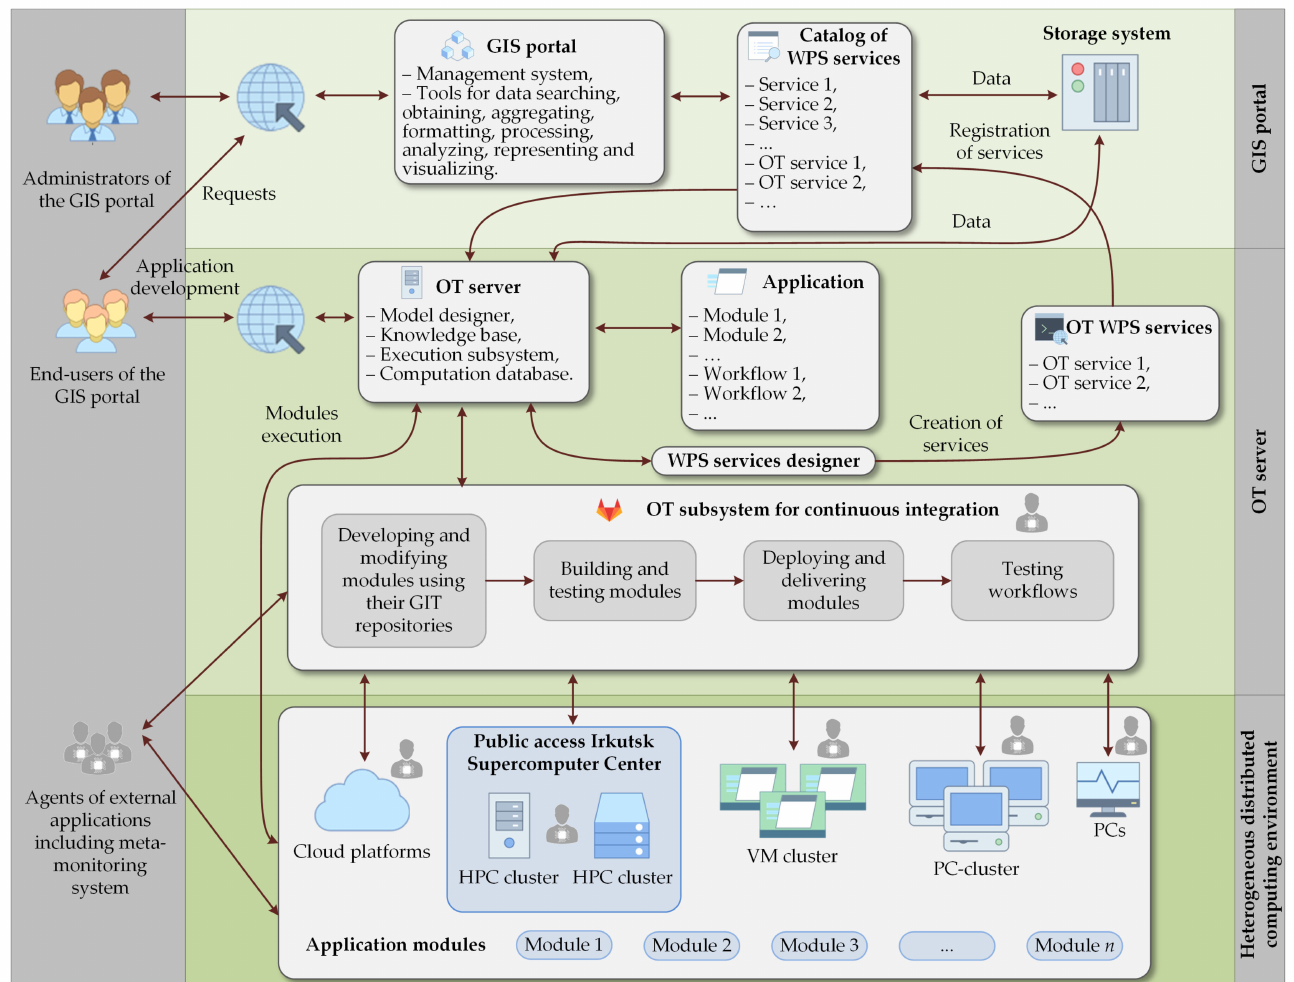
Figure 2. Scheme of operations with WPS services in